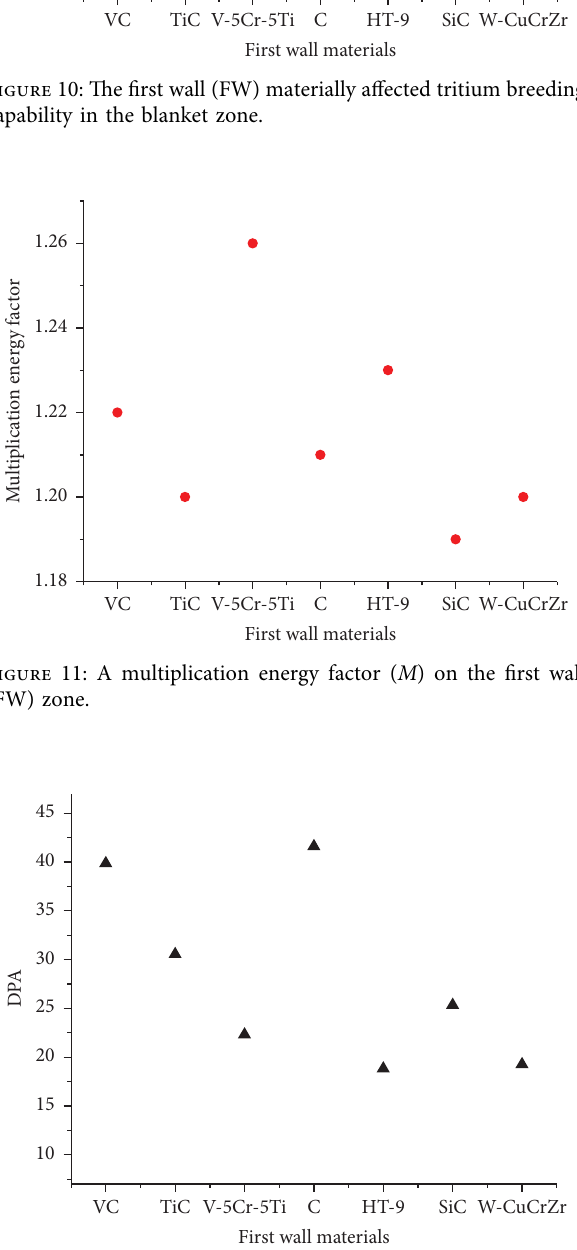
Figure 12: Radiation damage afects the material in